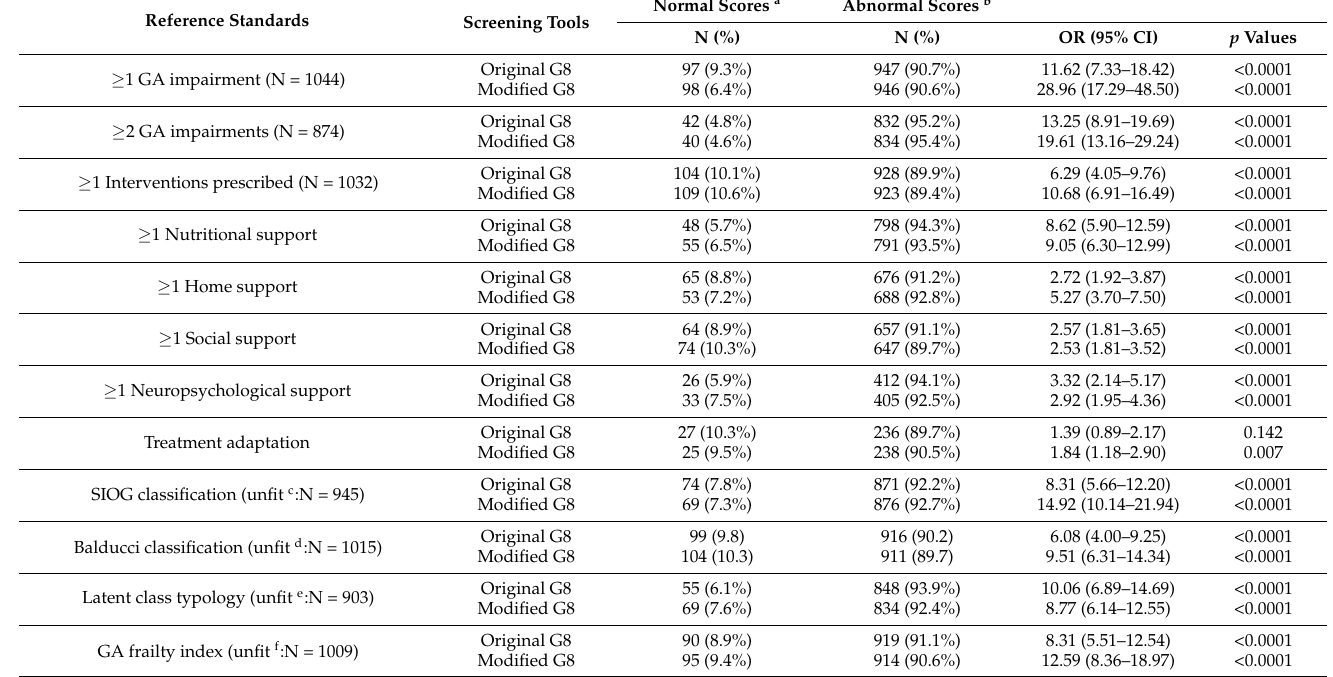
Table 3. Association between reference standards and both screening tools (original G8 and modified G8), N =